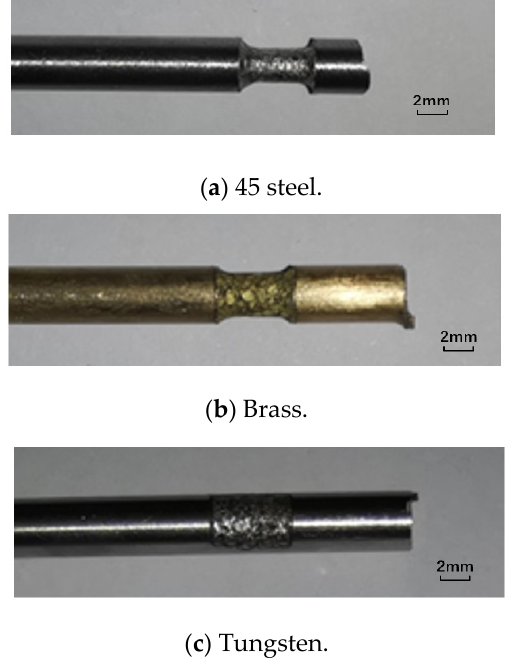
Figure 6. Absolute wear of three different electrode materials.